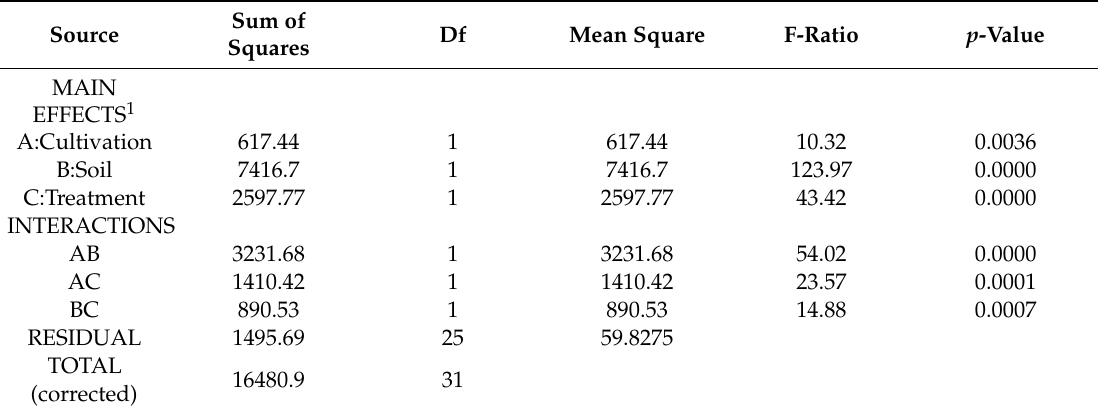
Table 2. Analysis of Variance for e ff ects of various factors on fresh weight of